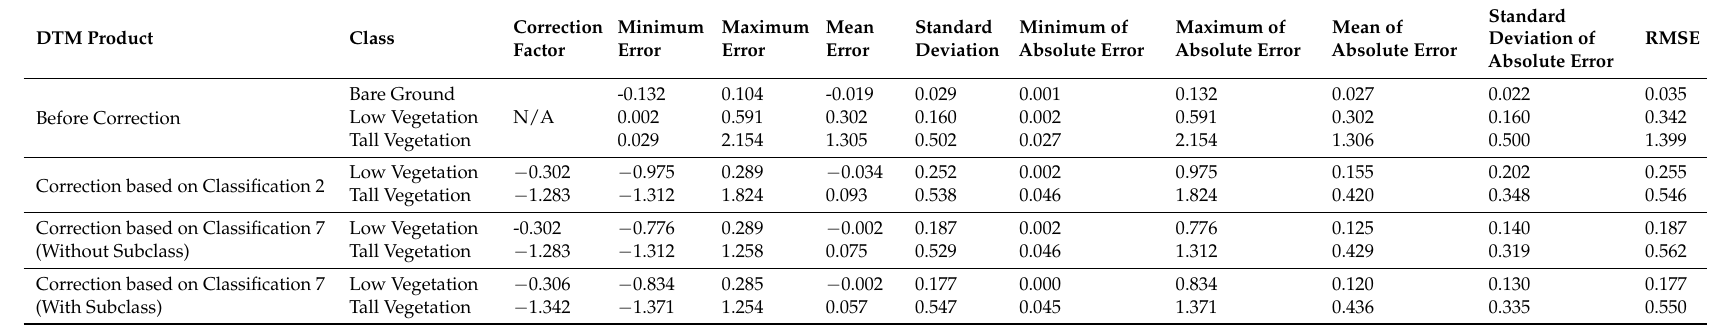
Table 3. Comparison of terrain correction results before and after classification correction and with or without subclass correction. “Before correction” refers to the SVM classification result based on orthophoto and mean statistics. “After correction (without subclass)” is the terrain correction result based on the corrected classification using the proposed new method. “After correction (with subclass)” further adds an additional subclass from both low and tall vegetation classes and applies adjusted terrain factors